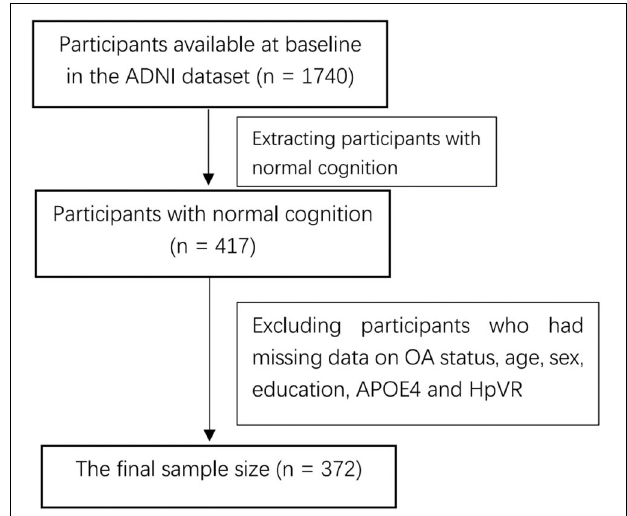
FIGURE 1 | Flowchart of the data selections at